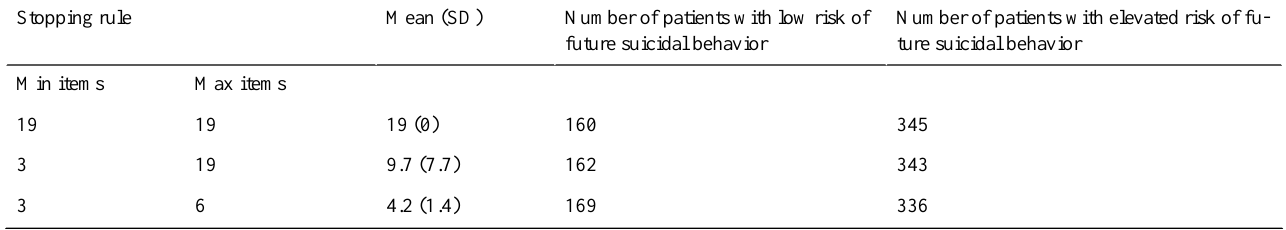
Table 4. Classification of risk for several stopping rules for Beck Scale for Suicide Ideation scores